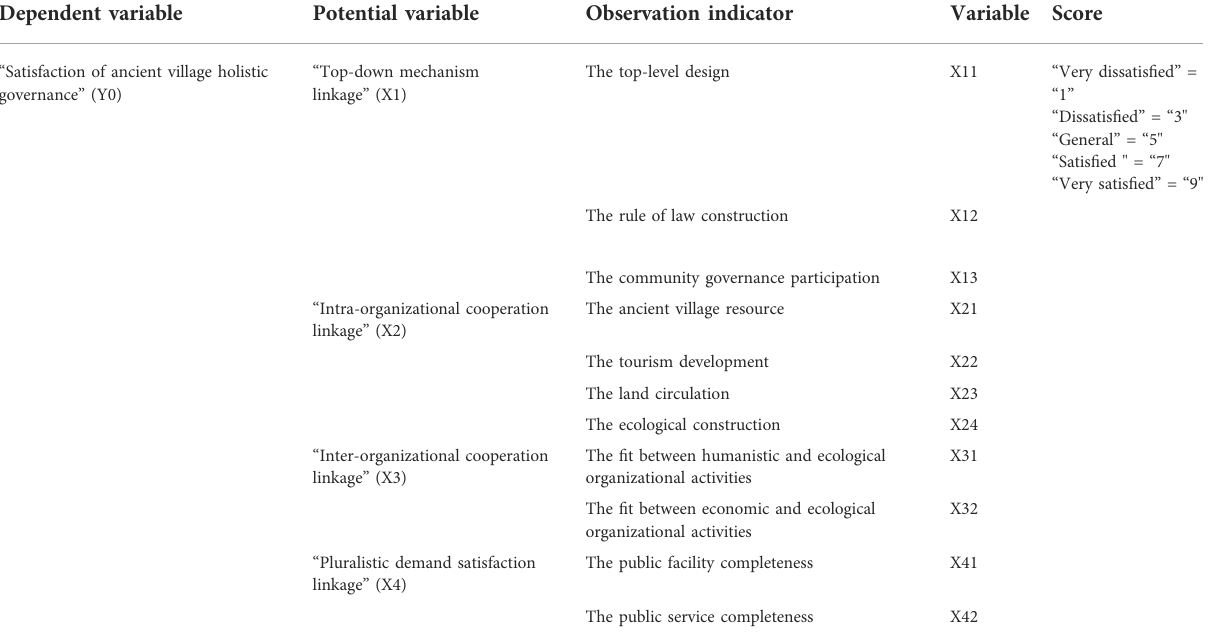
TABLE 2 Indicator operation assignment